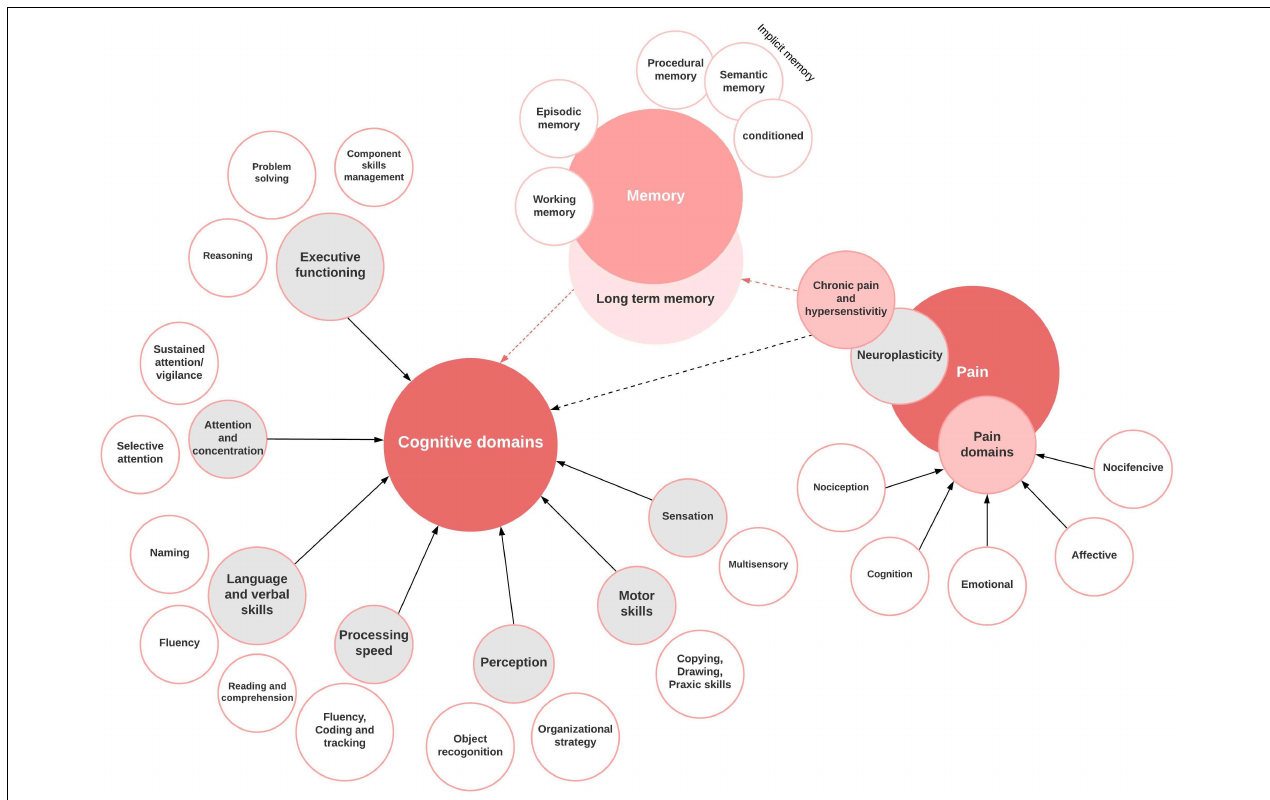
FIGURE 2 | Cognitive domains and the interconnectivity to pain perception and memory